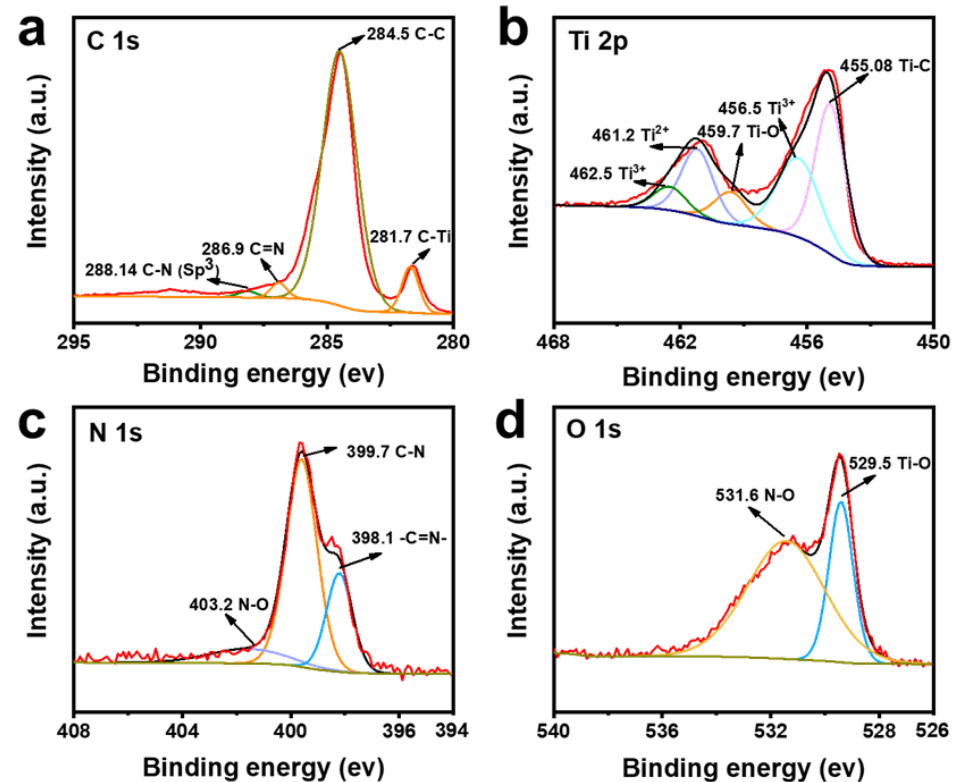
Figure 2. High-resolution C 1s ( a ), Ti 2p ( b ), N 1s ( c ), and O 1s ( d ) XPS spectra of TTPA-CONs/Ti 3 C 2 T x composites.